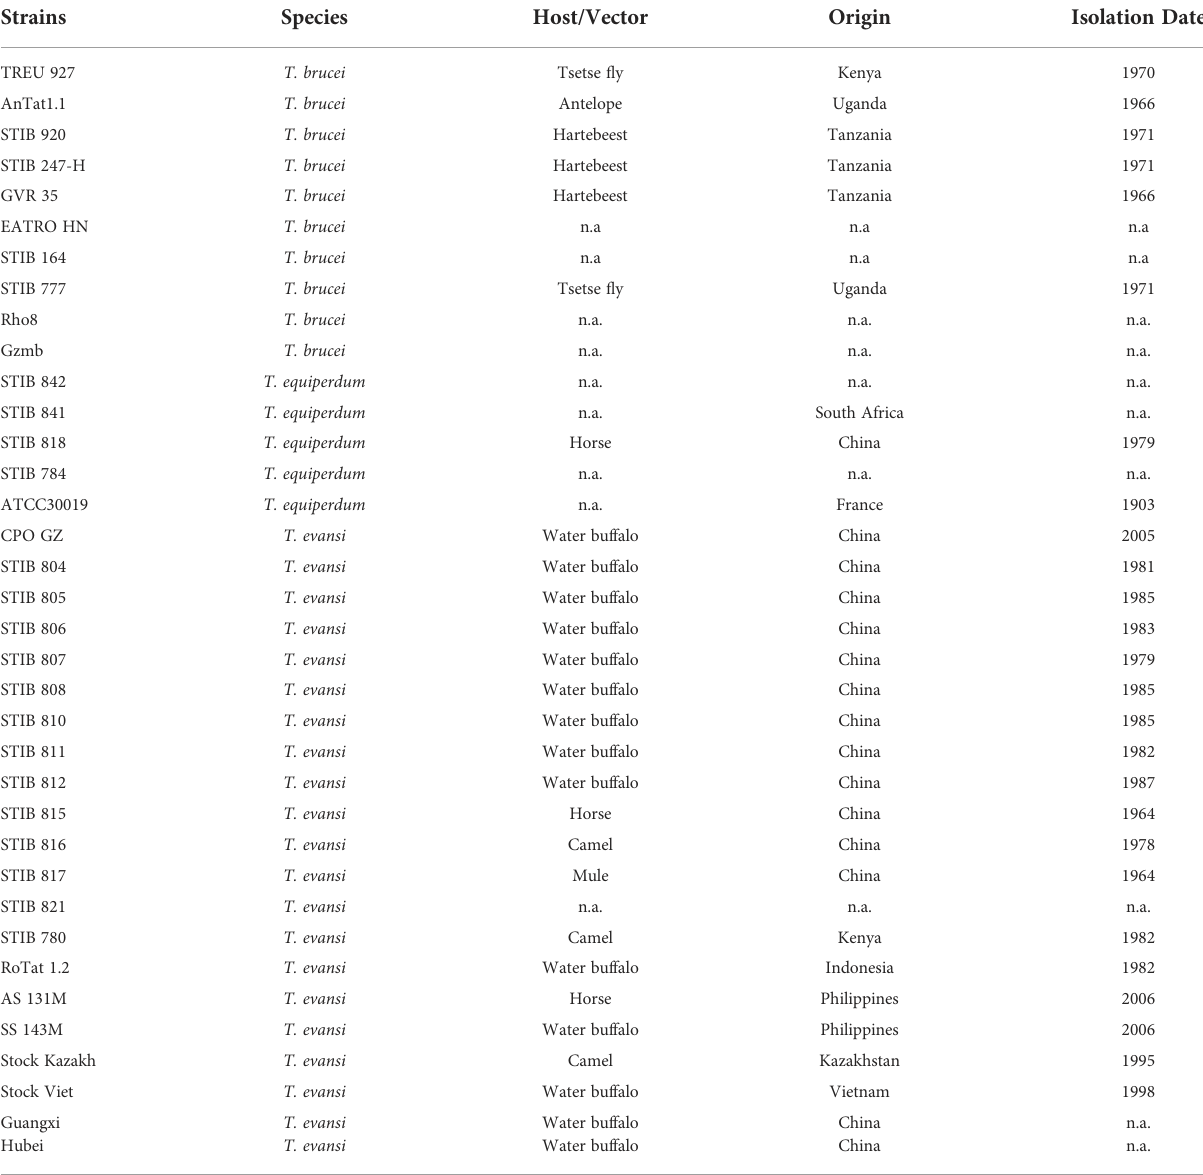
TABLE 1 Strains of Trypanozoon investigated in this study. Strains